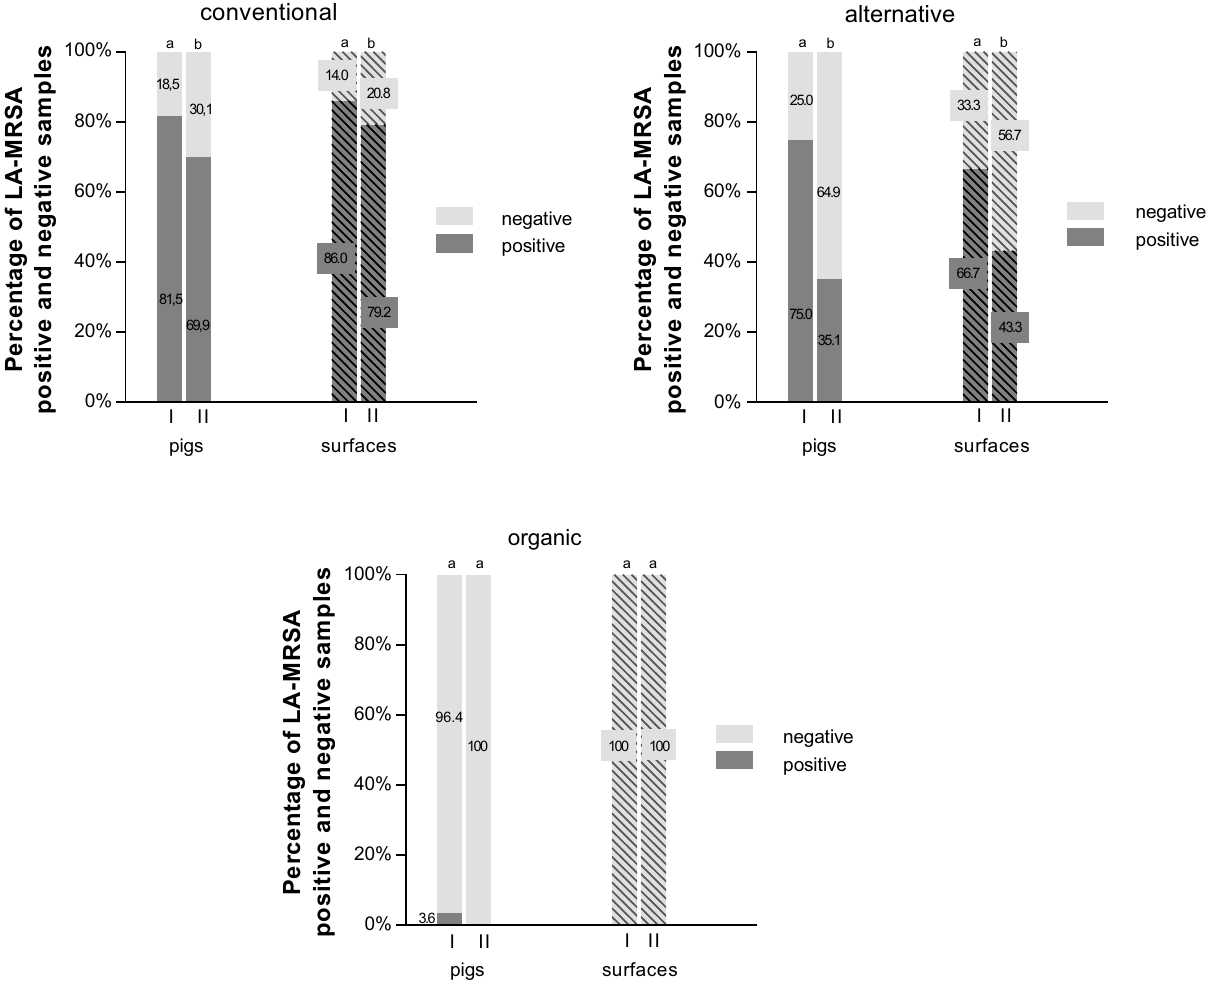
Figure 1. Percentage of LA-MRSA positive and negative samples at the beginning (I) and end of fattening period (II) in conventional (n = 2*256 pigs, n = 2*312 surfaces), alternative (n = 2*57 pigs, n = 2*60 surfaces)